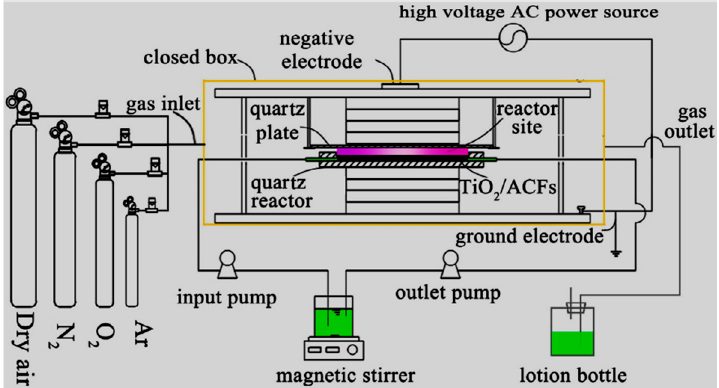
Figure 9. Experimental diagram of the dielectric barrier discharge (DBD) reactor used for the decomposition of triclocarban (TCC) [164].